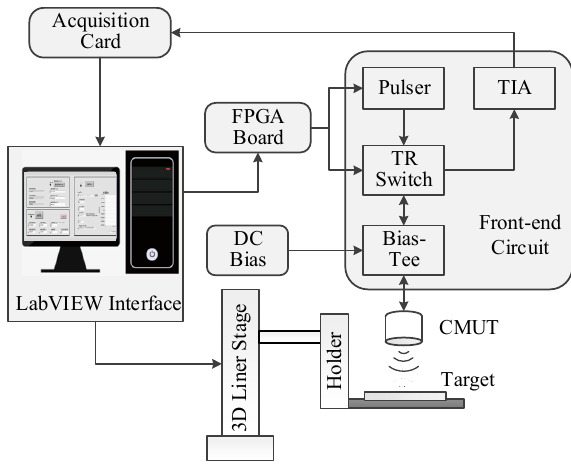
Figure 11. Schematic of burst-echo imaging.